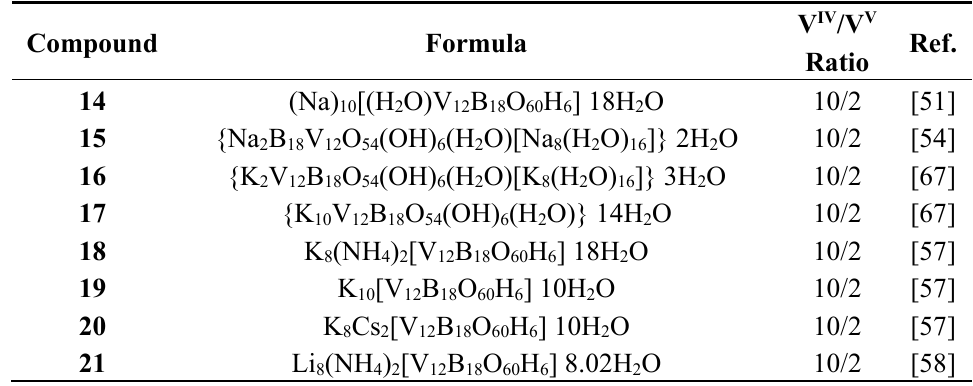
Table 3. List of the lattices with alkaline ions as counterbalancing cations. The mixed valence V IV /V V ratio is indicated for each lattice.